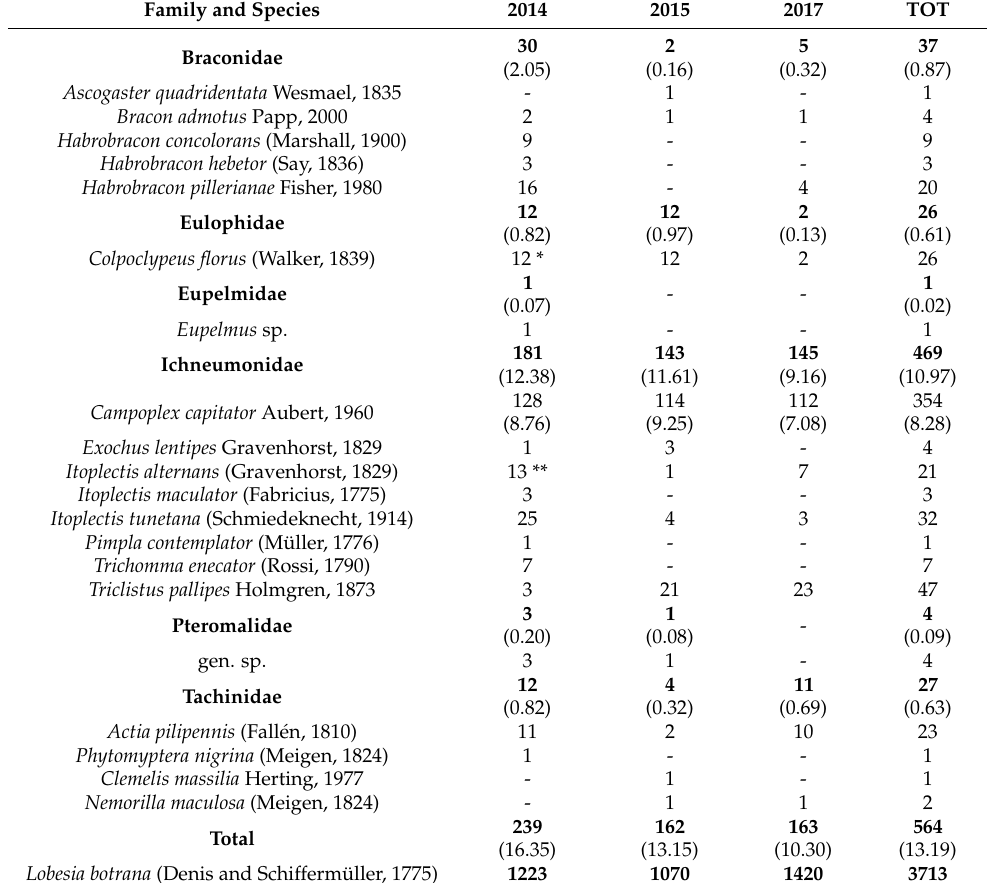
Table 1. Overall abundance of Lobesia botrana and its larval/pupal parasitoids (in bold) on Daphne gnidium over three years of field studies; family names and total number of parasitoids per family are in bold; for each parasitoid family as well as for Campoplex capitator, the host parasitisation rate (%) is given within